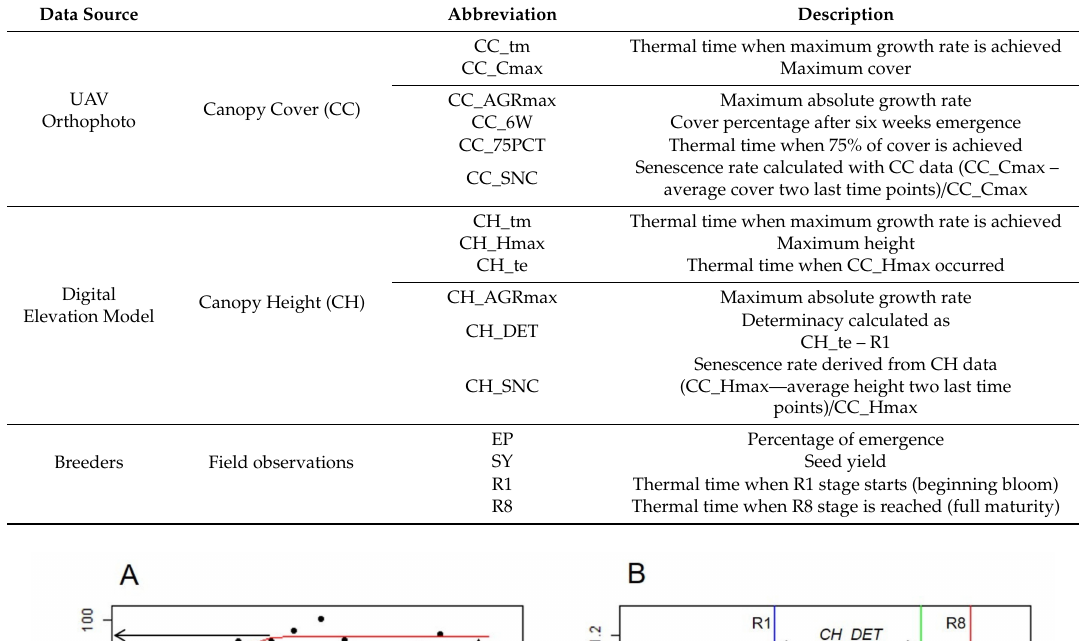
Table 1. Overview of the phenotypic parameters.